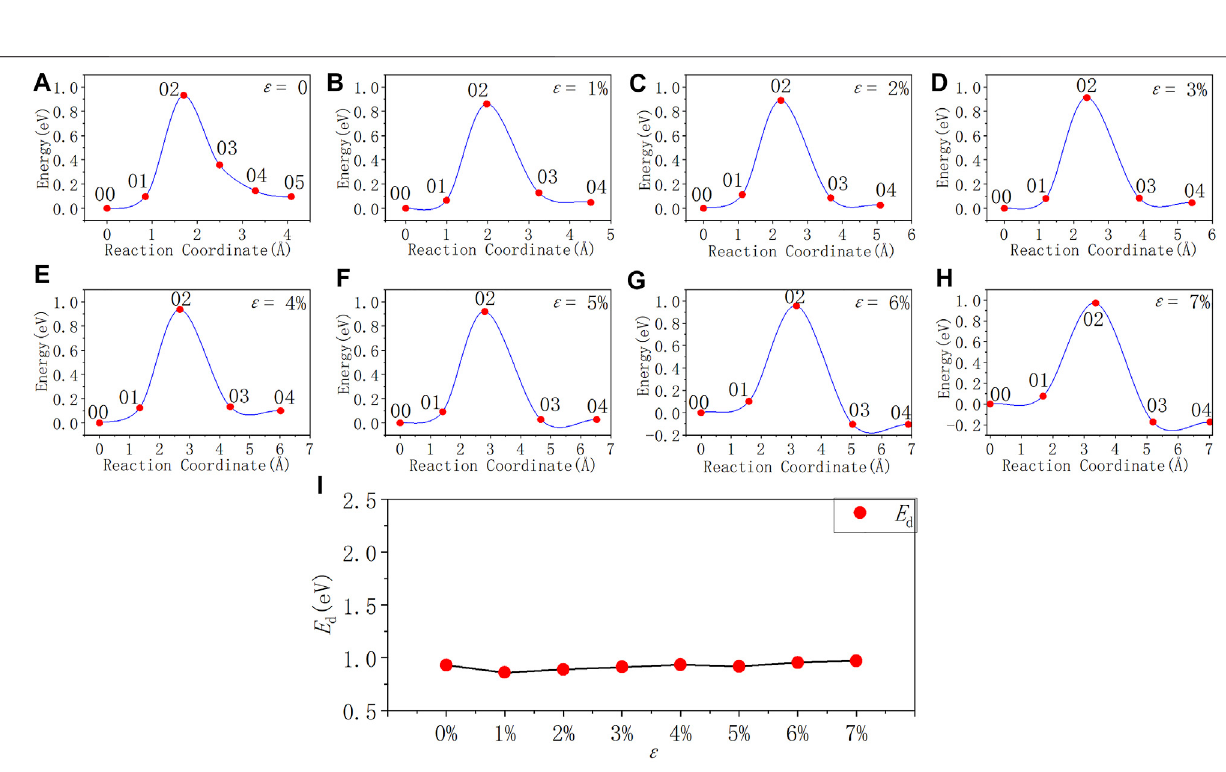
Frontiers in Materials |